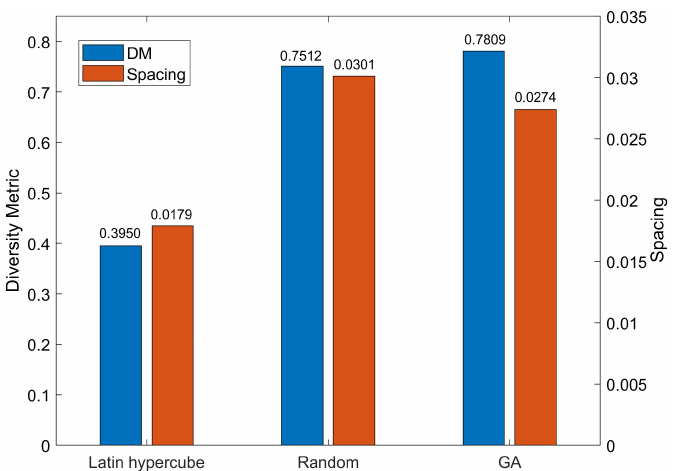
Figure 14. Performance metrics of the multi-objective optimization algorithm.